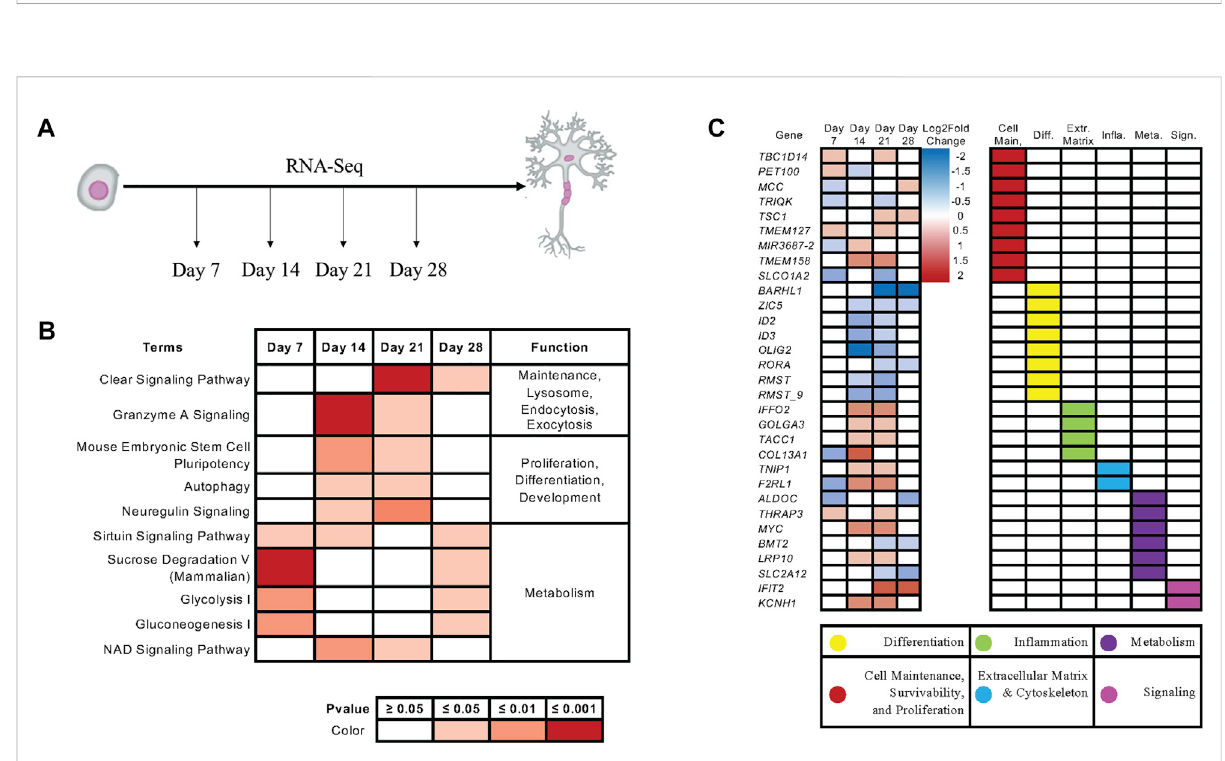
FIGURE 5 KIAA0319 KD RNA-Seq shows pathways that promote cell cycle arrest of neuronal progenitor cells. (A) RNA Sequencing performed at four distinct timepoints separated by 7-day intervals during cortical neuronal differentiation. (B) Ingenuity Pathway Analysis revealed enrichment of pathways appearing in multiple time points. (C) Ingenuity Pathway Analysis revealed enrichment of genes appearing in multiple time points.